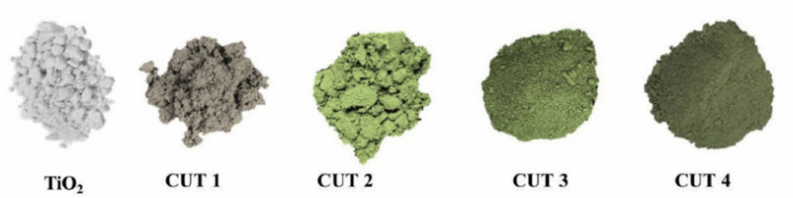
Figure 5. Colour of synthesized pristine and Cu-TiO 2 / CuO composite nanopowders. This figure is reprinted from [62], with permission from Elsevier, 2020.